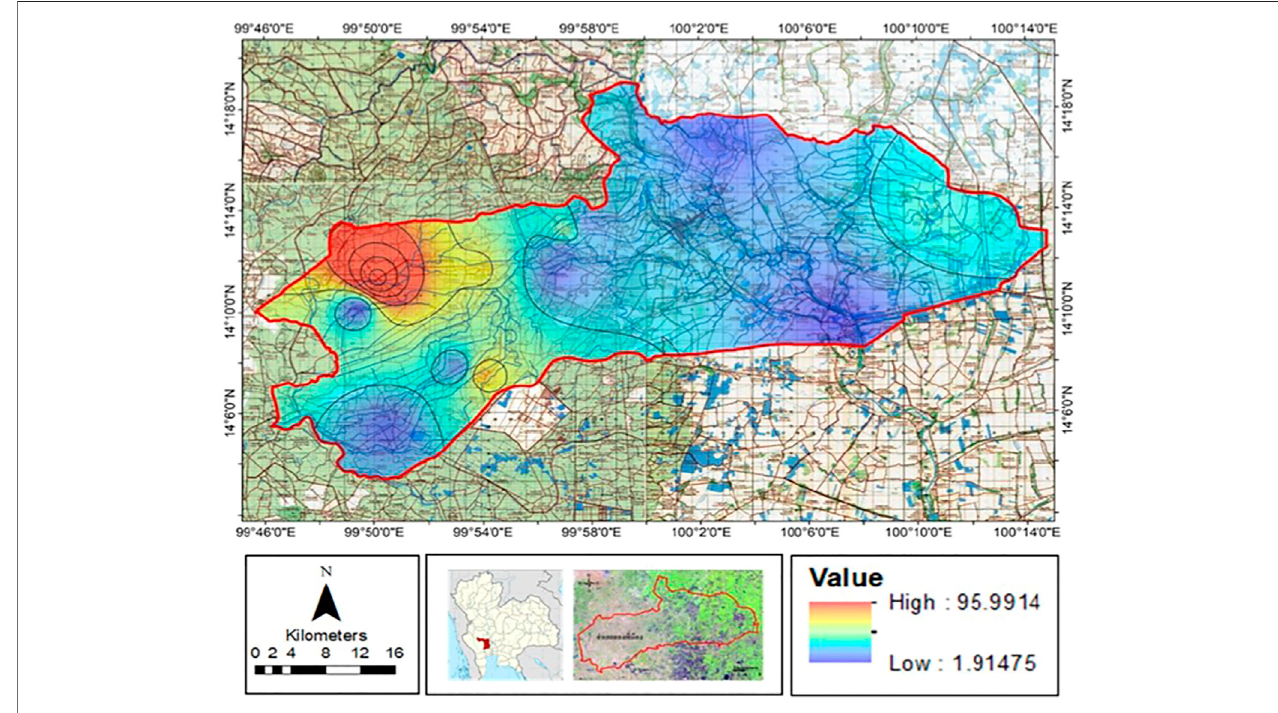
FIGURE 2 | Nitrate distribution in groundwater of the study